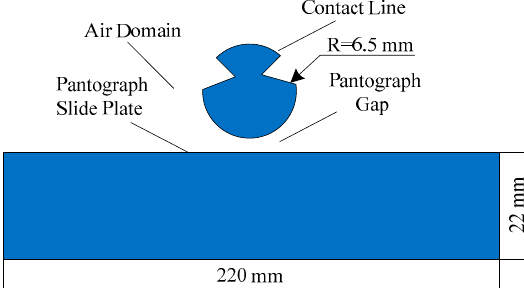
Figure 2. Simplified model of the pantograph–catenary system. Table 1. Contact line with carbon slide parameters.